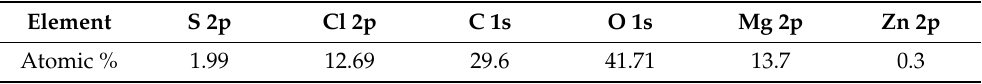
Figure 11. The XPS binding energy spectrum of corrosion products formed on AZ31 magnesium alloy exposed for 12 months in the marine environment of ocean voyage: ( a ) narrow scan spectrum of C 1s, ( b ) narrow scan spectrum of O 1s, ( c ) whole spectrum, ( d ) proportion of the different states of element O. Table 5. The XPS analysis of the corrosion products formed on AZ31 magnesium alloy exposed for 12 months.